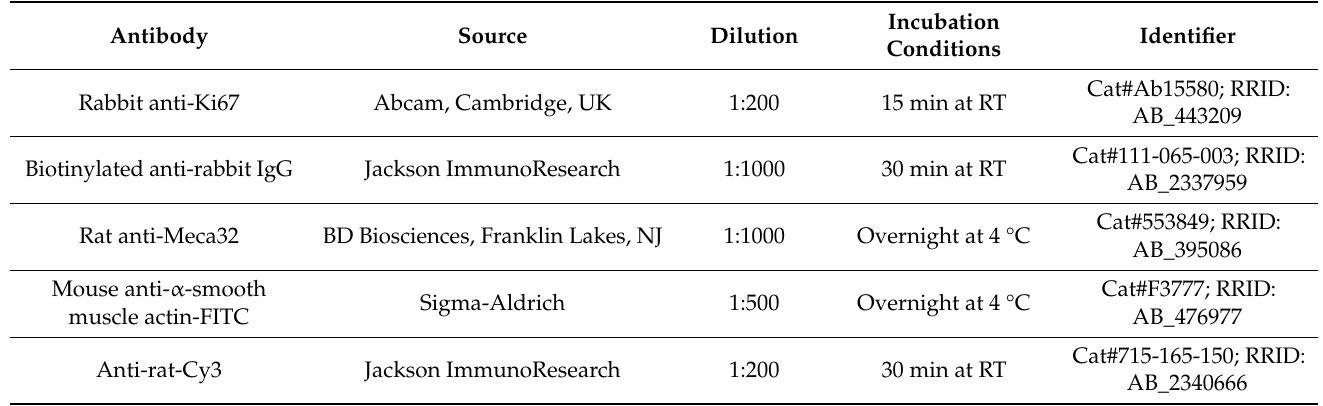
Table 2. Antibodies used for immunohistochemistry or immunofluorescence